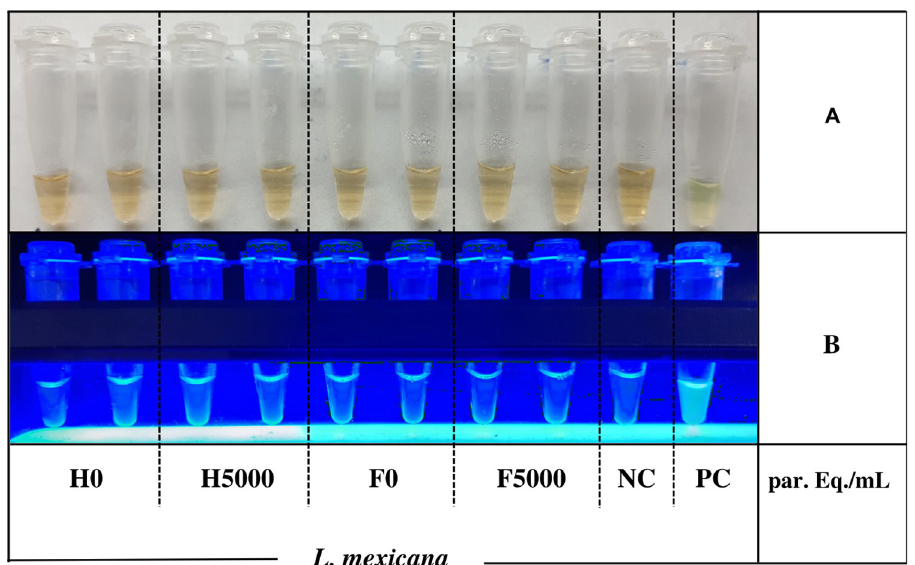
Fig 4. FTA cards and heparinized blood containing 5000 L . mexicana promastigotes per mL to explore exclusivity of LAMP after PURE DNA preparation. A) Naked eye; B) LF-160 light. Parasitic loads per mL of blood are indicated in the bottom of the Figure. F: FTA cards; H: heparinized blood; F0 and H0: non-spiked blood; NC: negative control; PC: positive control provided in the kit.